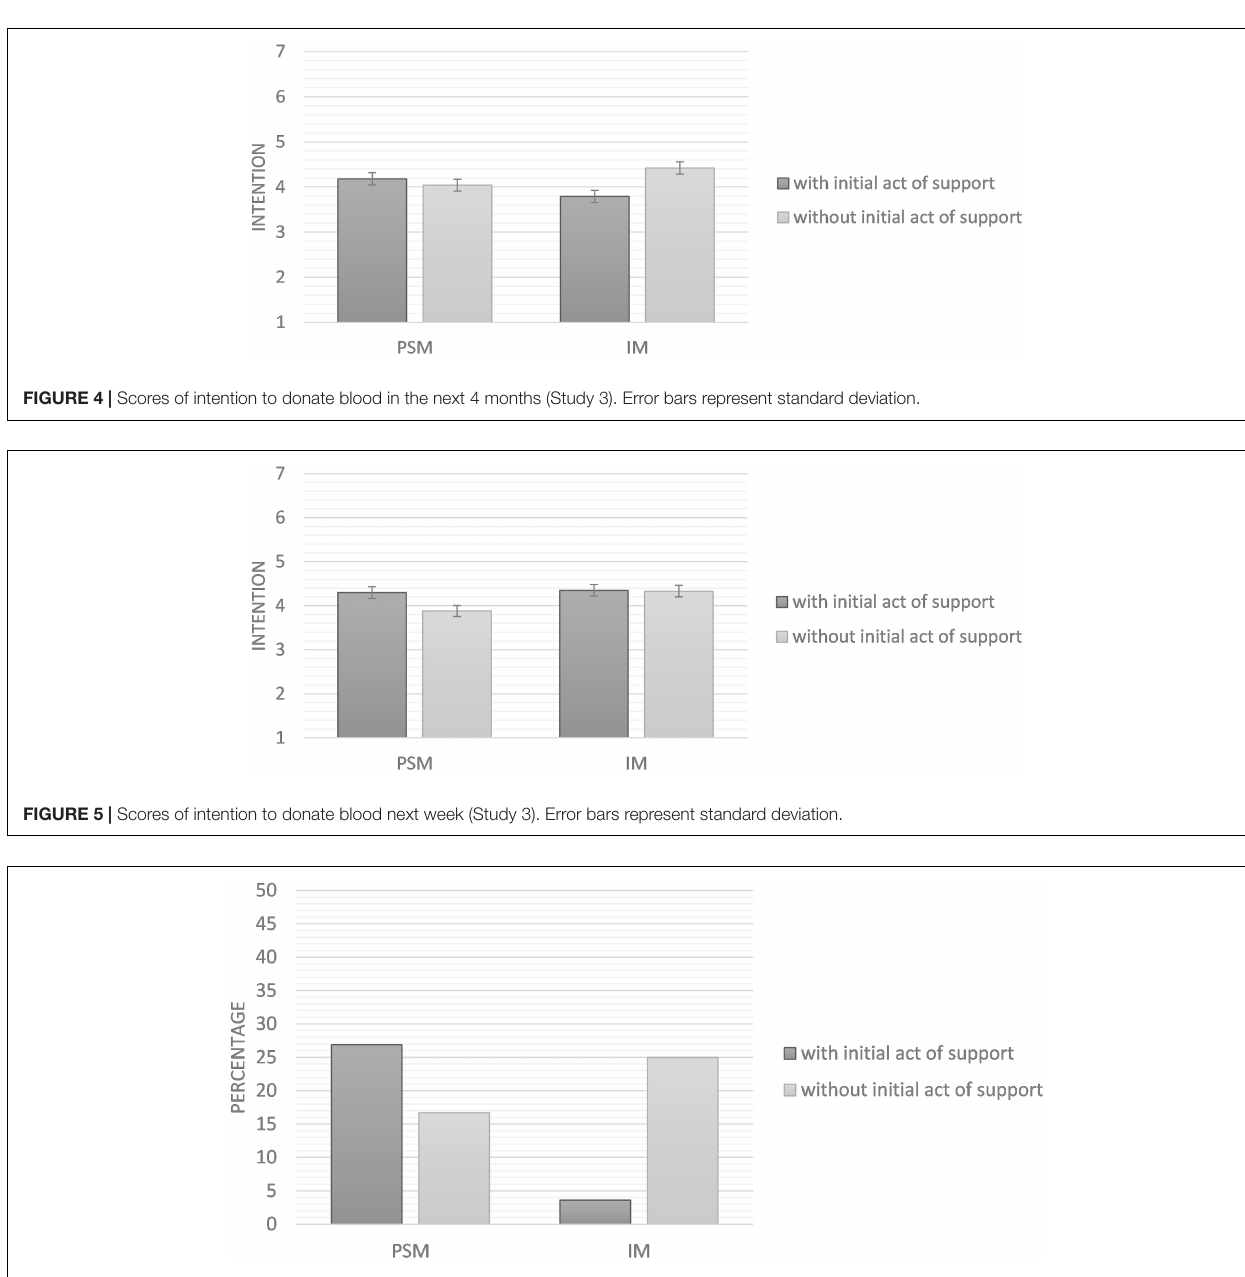
FIGURE 6 | Percentages of participants who donated blood (self-report) according to experimental conditions (Study